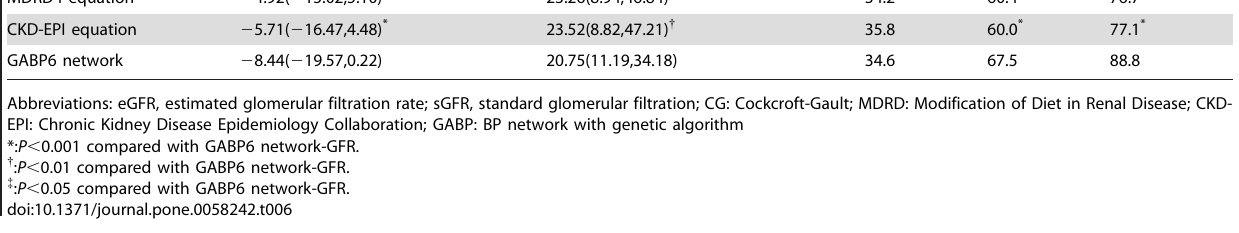
Median % Absolute difference (25%, 75% Percentile)